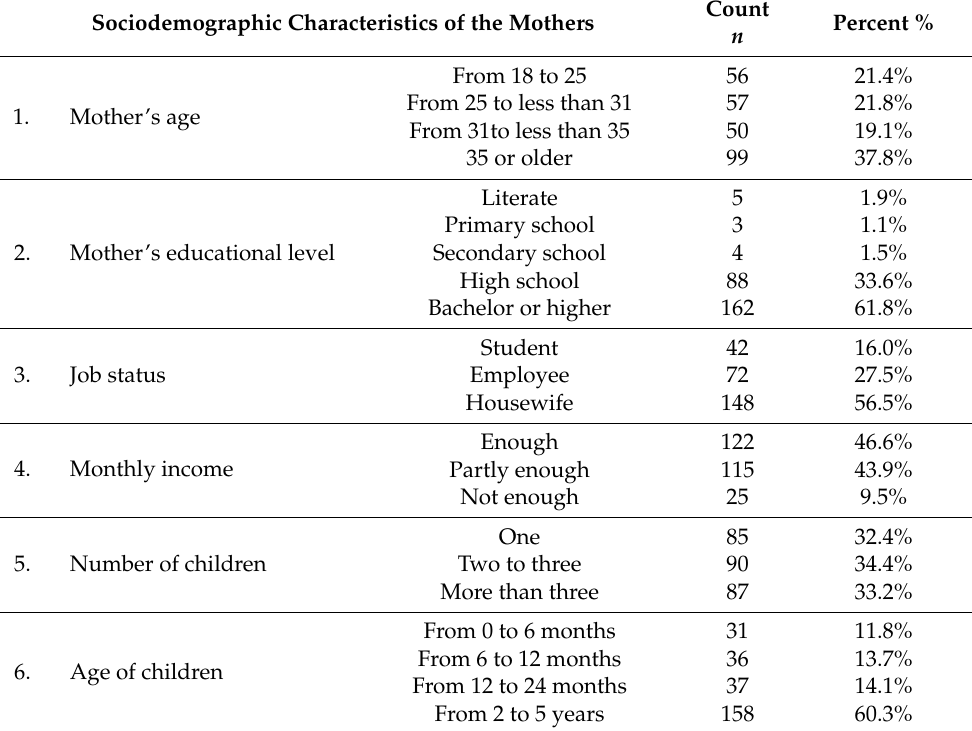
Table 1. Distributions according to the sociodemographic characteristics of the study’s participants. Sociodemographic Characteristics of the